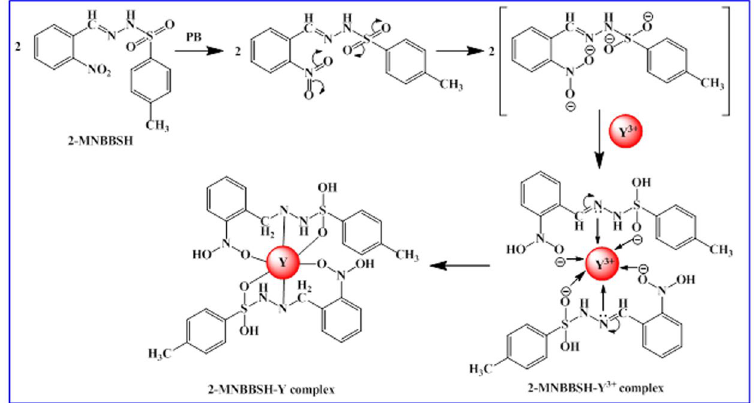
Figure 5. Possible mechanism of 2-MNBBSH-Y-complex